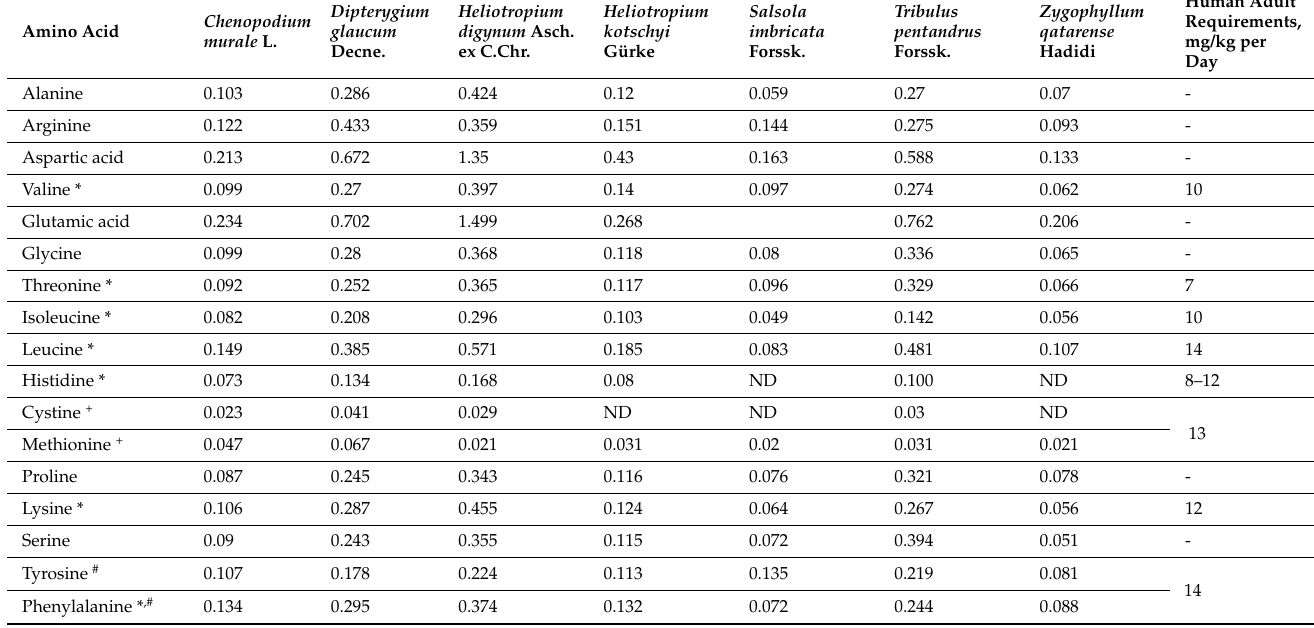
Table 1. Free amino acids contents (g/100 g) in the leaves of seven wild species from the United Arab